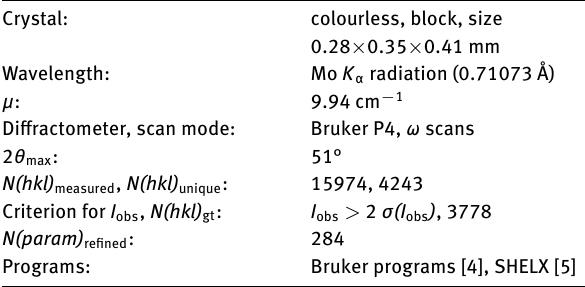
Table 1: Data collection and handling.